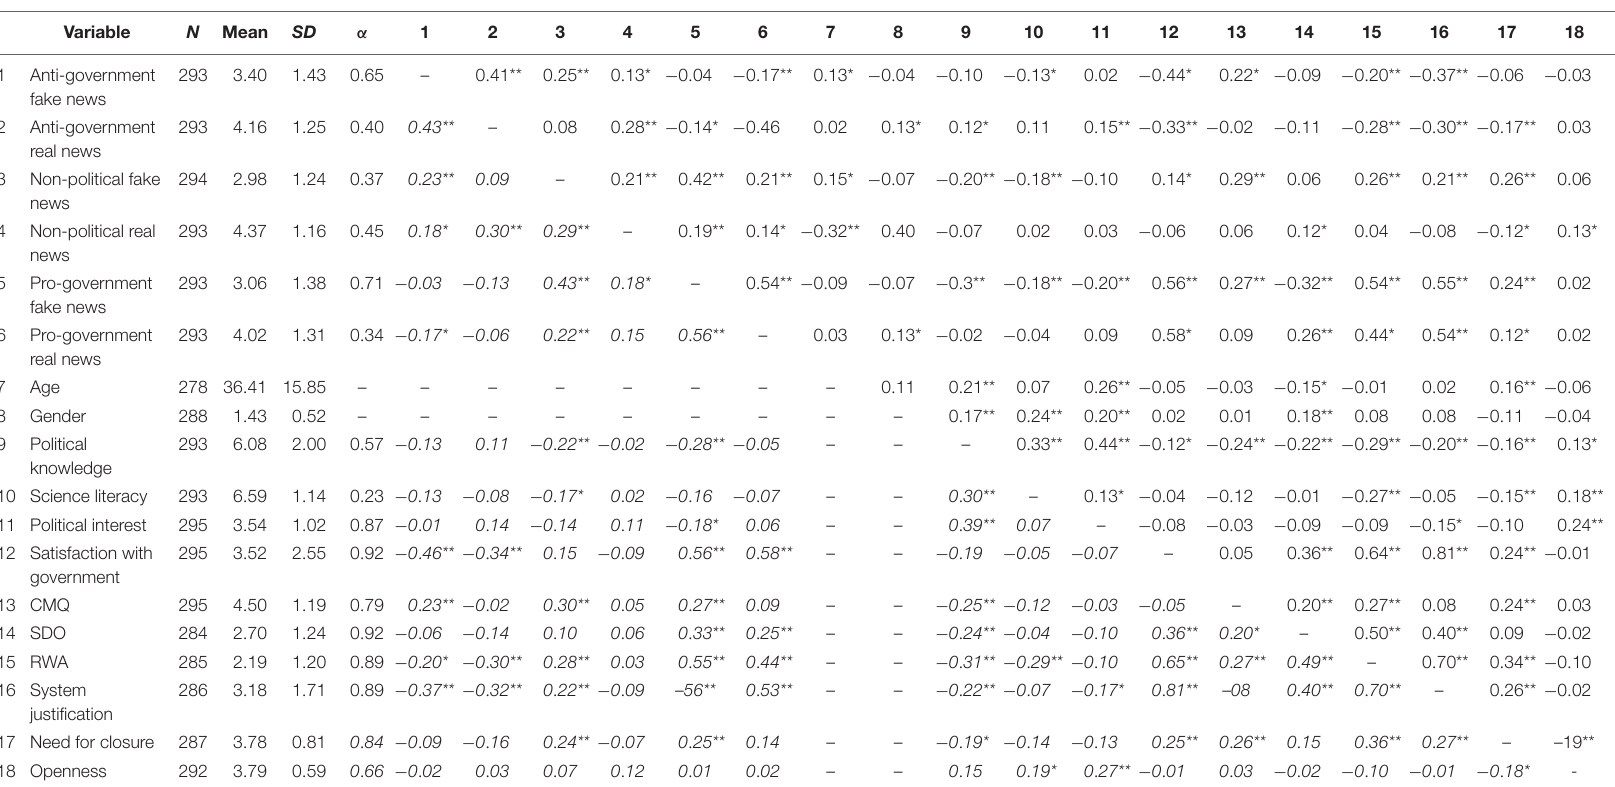
TABLE 2 | Descriptive statistics and correlations for study